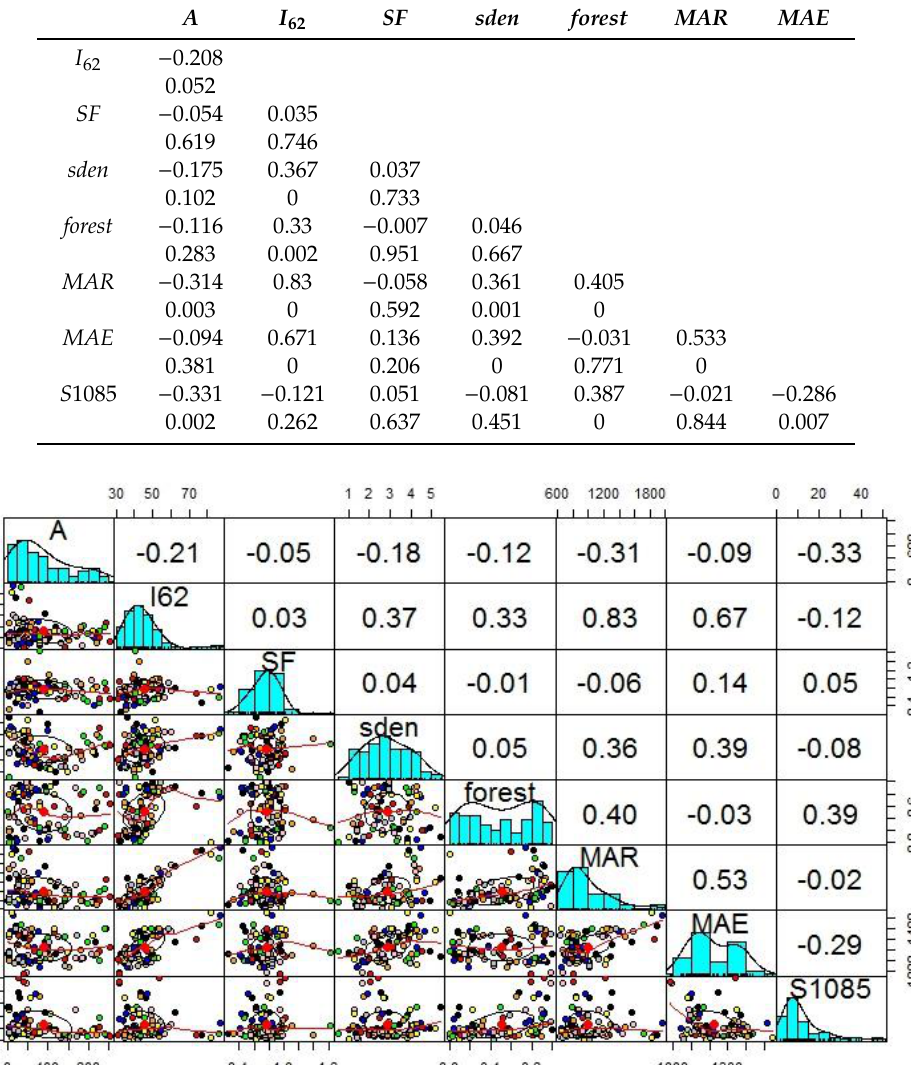
Table 2. Correlation coe ffi cients with their corresponding p -values between the independent variables.